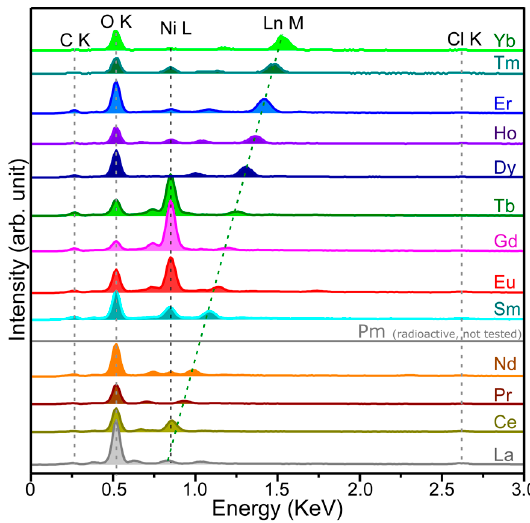
Figure 3. Energy-dispersive X-ray spectroscopy (EDXS) data for electrodeposited RE elements over a Ni sheet.